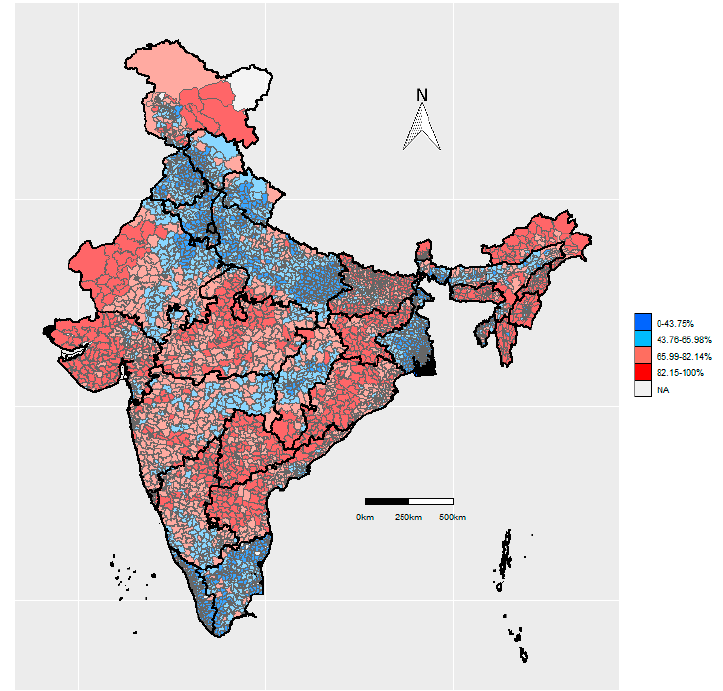
Figure 1. Maps showing OV > 5 km% (the percentage of villages where the nearest facility was outside the village and over 5km away) per AC. We show maps for Anganwadi centers ( a ), government pre-primary schools ( b ), private pre-primary schools ( c ), government primary schools ( d ), private primary schools ( e ), government middle schools ( f ), private middle schools ( g ), government secondary schools ( h ), private secondary schools ( i ), government senior secondary schools ( j ), and private senior secondary schools ( k ), Colors represent quartiles, ranging from blue (lowest deprivation) to red (highest